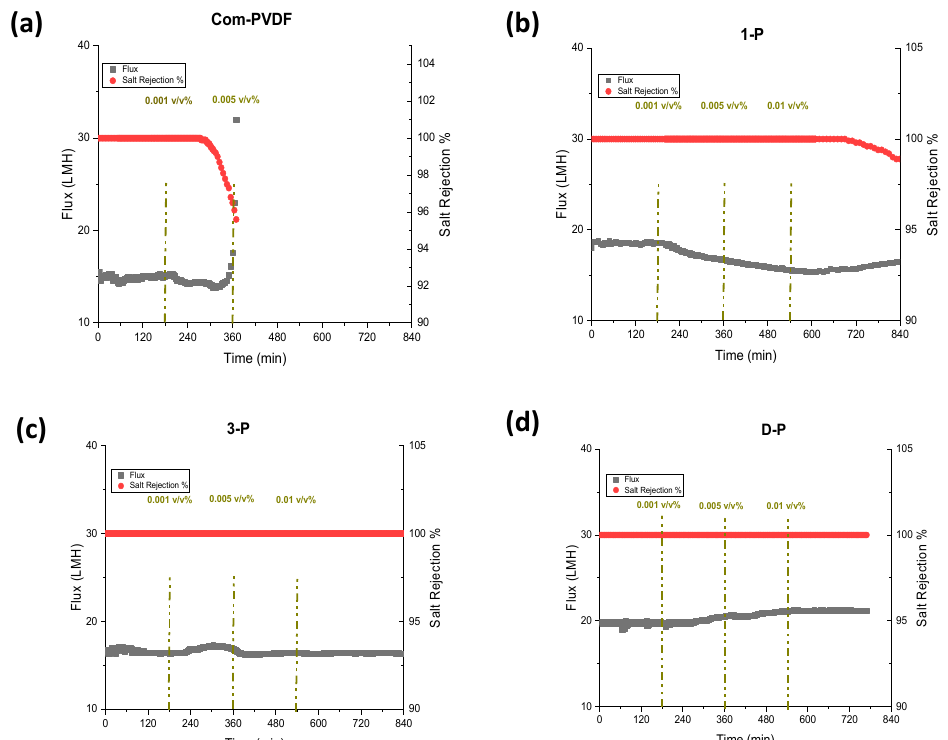
Figure 4. DCMD and anti-oil fouling performance showing flux and rejection for the commercial and the inkjet modified membranes: ( a ) Commercial PVDF membrane, ( b ) 1-P (1 layer inkjet coating), ( c ) 3-P (3-layer inkjet coating), and ( d ) D-P (double-sided 3-layer inkjet coating). The DCMD test was carried out at feed/permeate inlet temperatures of 60/20 °C and using 35 g/L NaCL solution with and without mineral oil addition of 0.001, 0.005, and 0.01 v/v% at 3 h interval. The 3-P membrane (Figure 4c) showed a lower flux than the 1-P membrane but